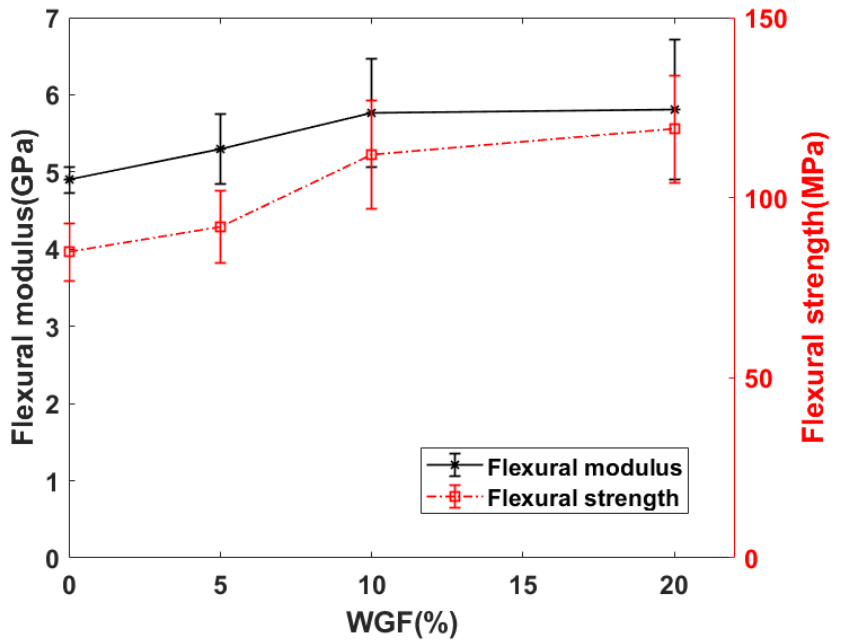
Figure 9. Flexural properties of WGF composites. Table 2. Comparison of specific flexural properties with